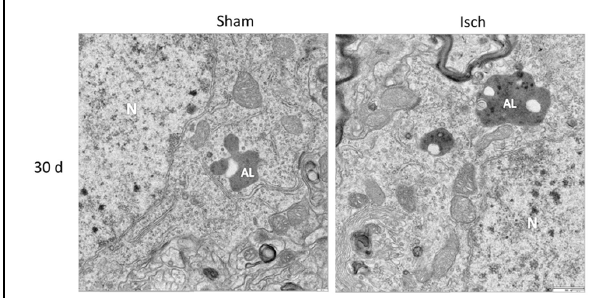
FIGURE 5 | Autophago-lysosomes at 30 days post-ischemia. Detection of Autophago-lysosomes (ALs) and bubble-like (BL). Representative images obtained from SS-Cx cortex of sham and ischemic rats at 30 days post-stroke by TEM.